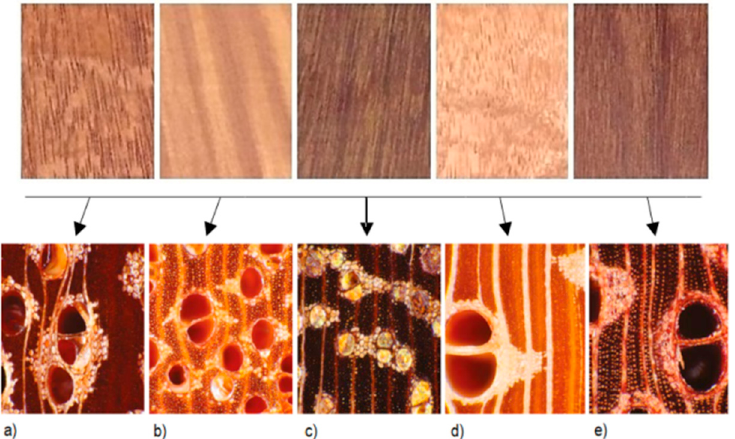
Figure 1. Microscopic structure (cross-section) of tropical tree species from listed as ( a ) Cumaru, ( b ) ( b ) Garapa, ( c ) Ipe, and the two remaining in Asia, ( d ) Kempas, ( e ) Garapa, ( c ) Ipe, and the two remaining in Asia, ( d ) Kempas, ( e ) Merbau.